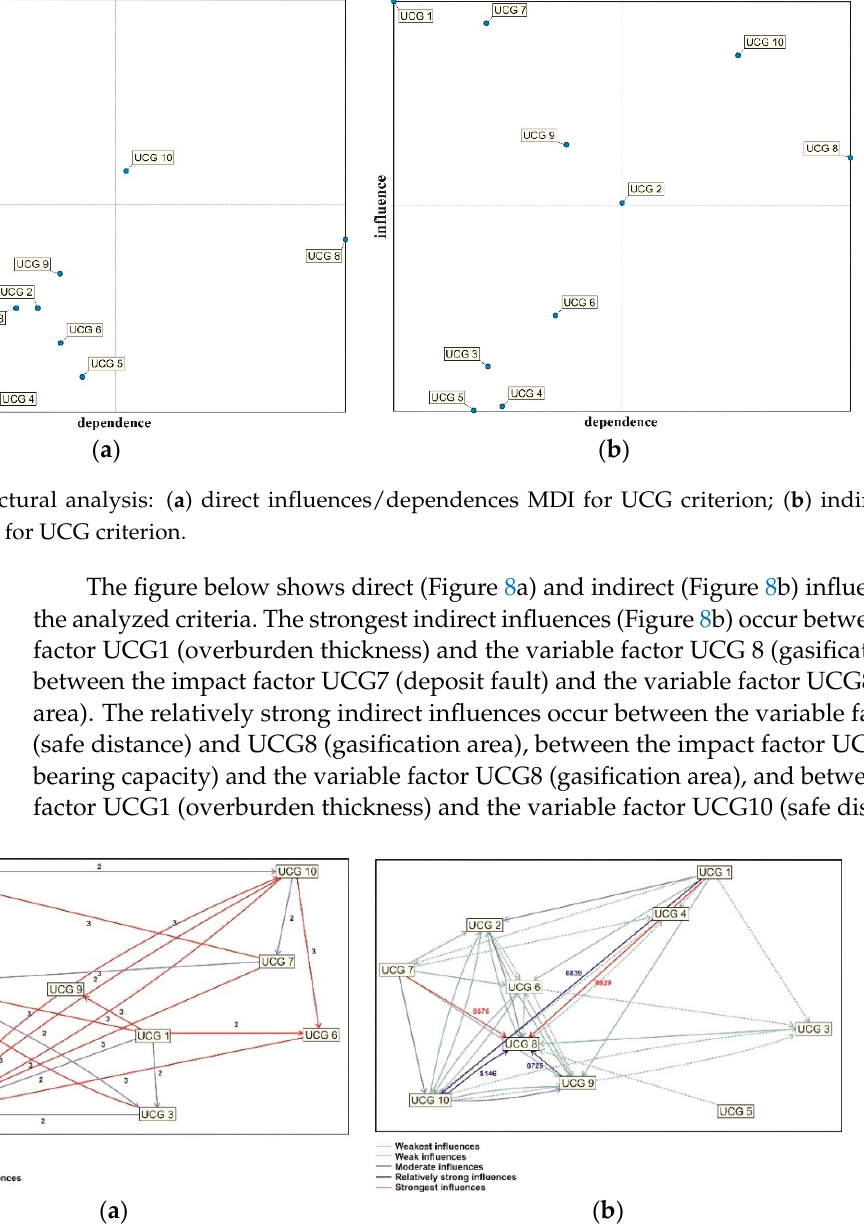
Table 3. Summary of structural analysis using MICMAC.